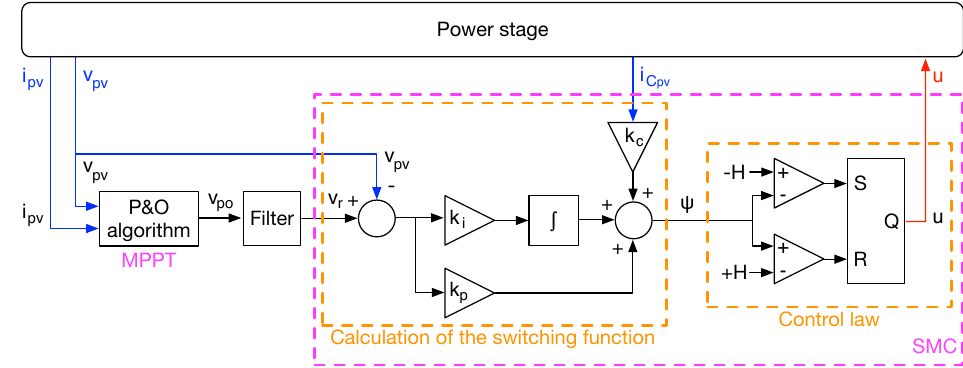
Figure 7. Block diagram of the proposed SMC (measured signals: blue lines; control signal: red